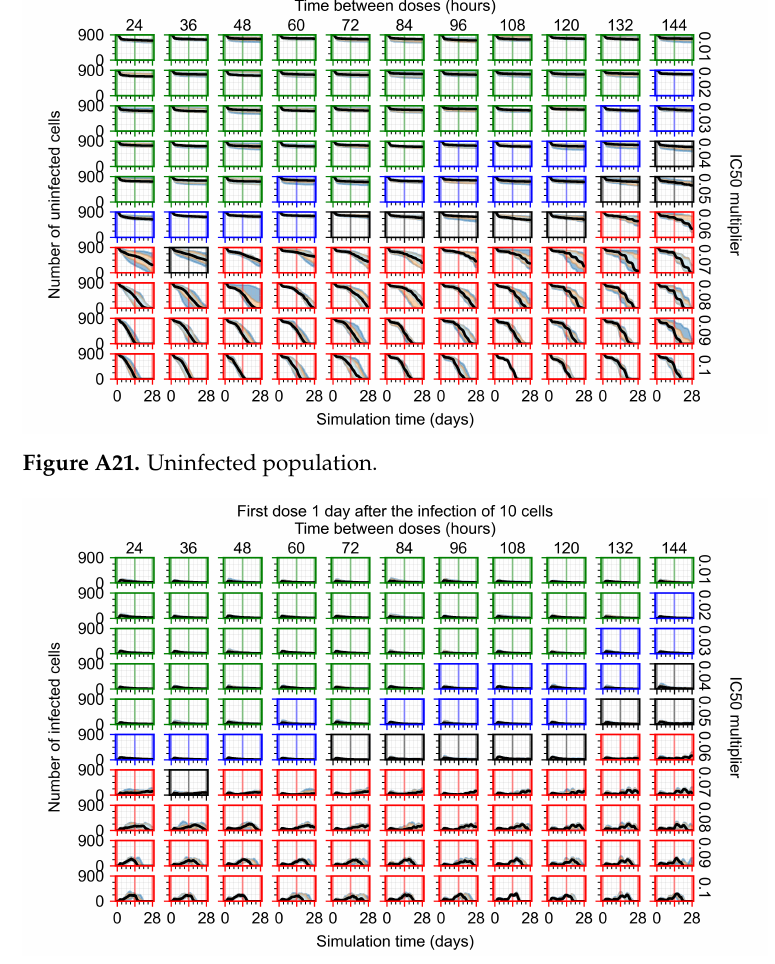
Figure A22. Infected (eclipse phase)